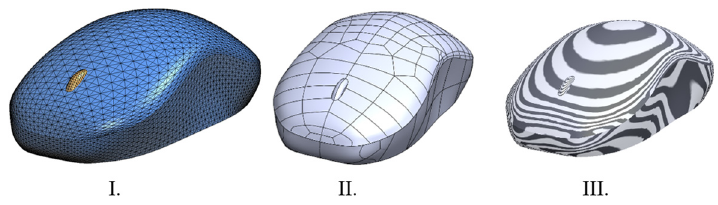
Figure 3. Solid body conversion. ( I ) Exported mesh file. ( II ) Solid body created from surface patches. ( III ) Applied zebra stripes.